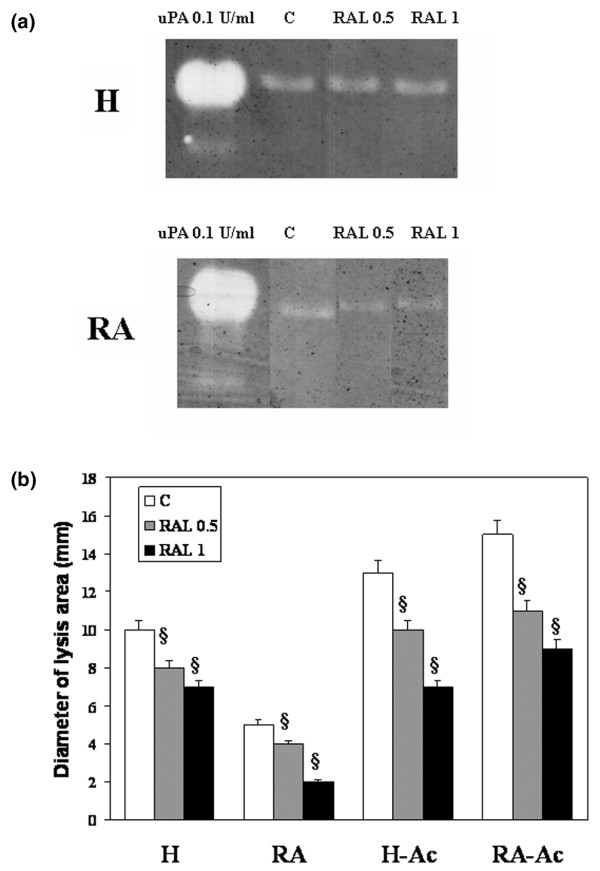
Urokinase-type plasminogen activator (u-PA) activity in healthy (H) and rheumatoid arthritis (RA) synoviocytes treated with Raloxifene (RAL). Samples were analyzed both in basal conditions and after treatment with 0.5 and 1 μM RAL (48 h). (a) Zymographic assay of aliquots of the culture medium. u-PA digestion of plasminogen shows clear bands of lysis in the cloudy casein background of the indicating layer. Shown here are the effects on one H and one RA line; the other lines furnished similar results. (b) Direct fibrinolytic assay of cell membrane-associated plasminogen activators. Left side: lysis areas of culture medium under the indicated experimental conditions. Right side: lysis areas of aliquots of the acidic wash (Ac), indicating the activity eluted from the cell surface. The diameter (mm) of the lysis areas were measured as an index of fibrin digestion. H refers to four different synovial cell cultures from healthy individuals; RA refers to synovial cell cultures from four different RA patients Each point represents the mean ± standard deviation of three experiments performed in triplicate on each synovial cell line. § = p < 0.01 versus control (C).